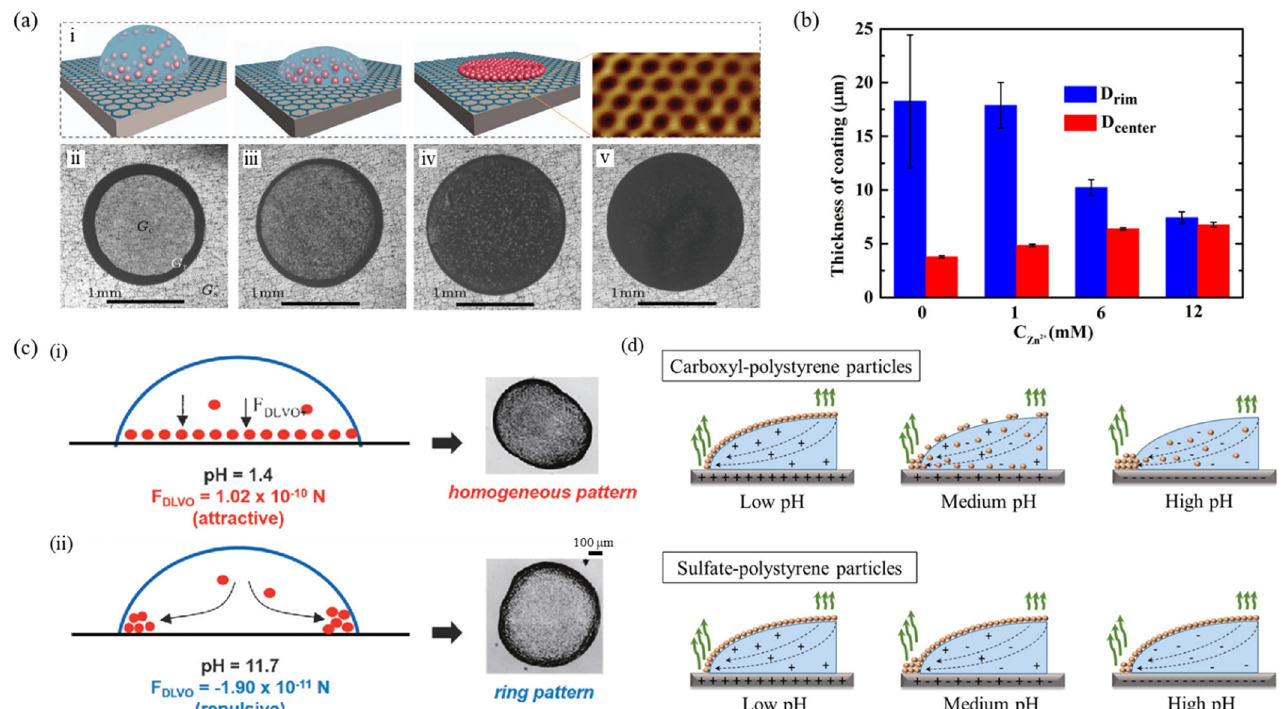
Figure 3. ( a ) (i) Schematic of how cations in a drop (blue hemisphere) determine the deposition of PS microspheres (red spheres). Inset shows an atomically resolved scanning tunneling microscope (STM) image of a graphene lattice. (ii)–(v) Optical microscopy images of particle patterns on graphene after evaporation of mixture drops with different salt concentrations (0 mM, 2.0 mM, 4.0 mM, and 8.0 mM, respectively) (reproduced with permission from ref. [67]. Copyright 2020 Chinese Physical Society and IOP Publishing Ltd.). ( b ) Average thickness at rim and center of PS microsphere suspension mixed with different concentrations of complexed Zn 2+ (0, 1.0, 6.0, and 12.0 mM), after evaporation of the sessile drops on the iron surface (reproduced with permission from ref. [71]. Copyright 2020 American Chemical Society). ( c ) Influence of pH-dependent DLVO interactions of particles with the liquid-solid interface on the deposit morphology from drops of titania nanoparticles drying on glass substrates at (i) acidic and (ii) basic conditions (scale bar is 100 μ m) (reproduced with permission from ref. [117]. Copyright 2010 American Chemical Society). ( d ) Schematic of carboxyl- and sulfate-PS particle deposits at different pH levels (reproduced with permission from ref. [118]. Copyright 2018 Elsevier).